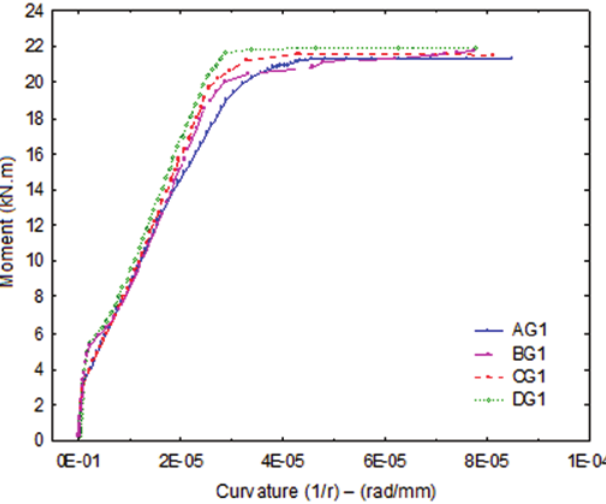
Bending moment-curvature diagram for